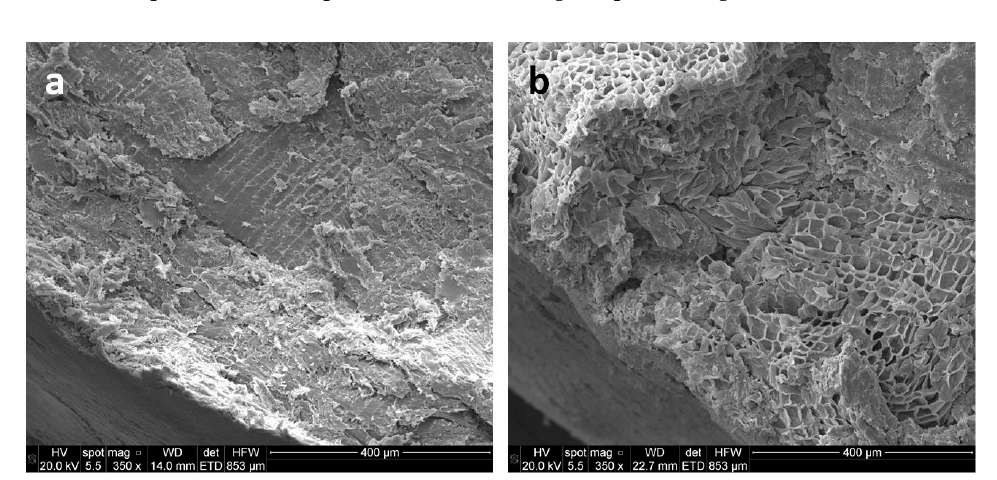
Figure 6. SEM images for transversal section of eucalyptus ( a ) and cork ( b ) wastes.